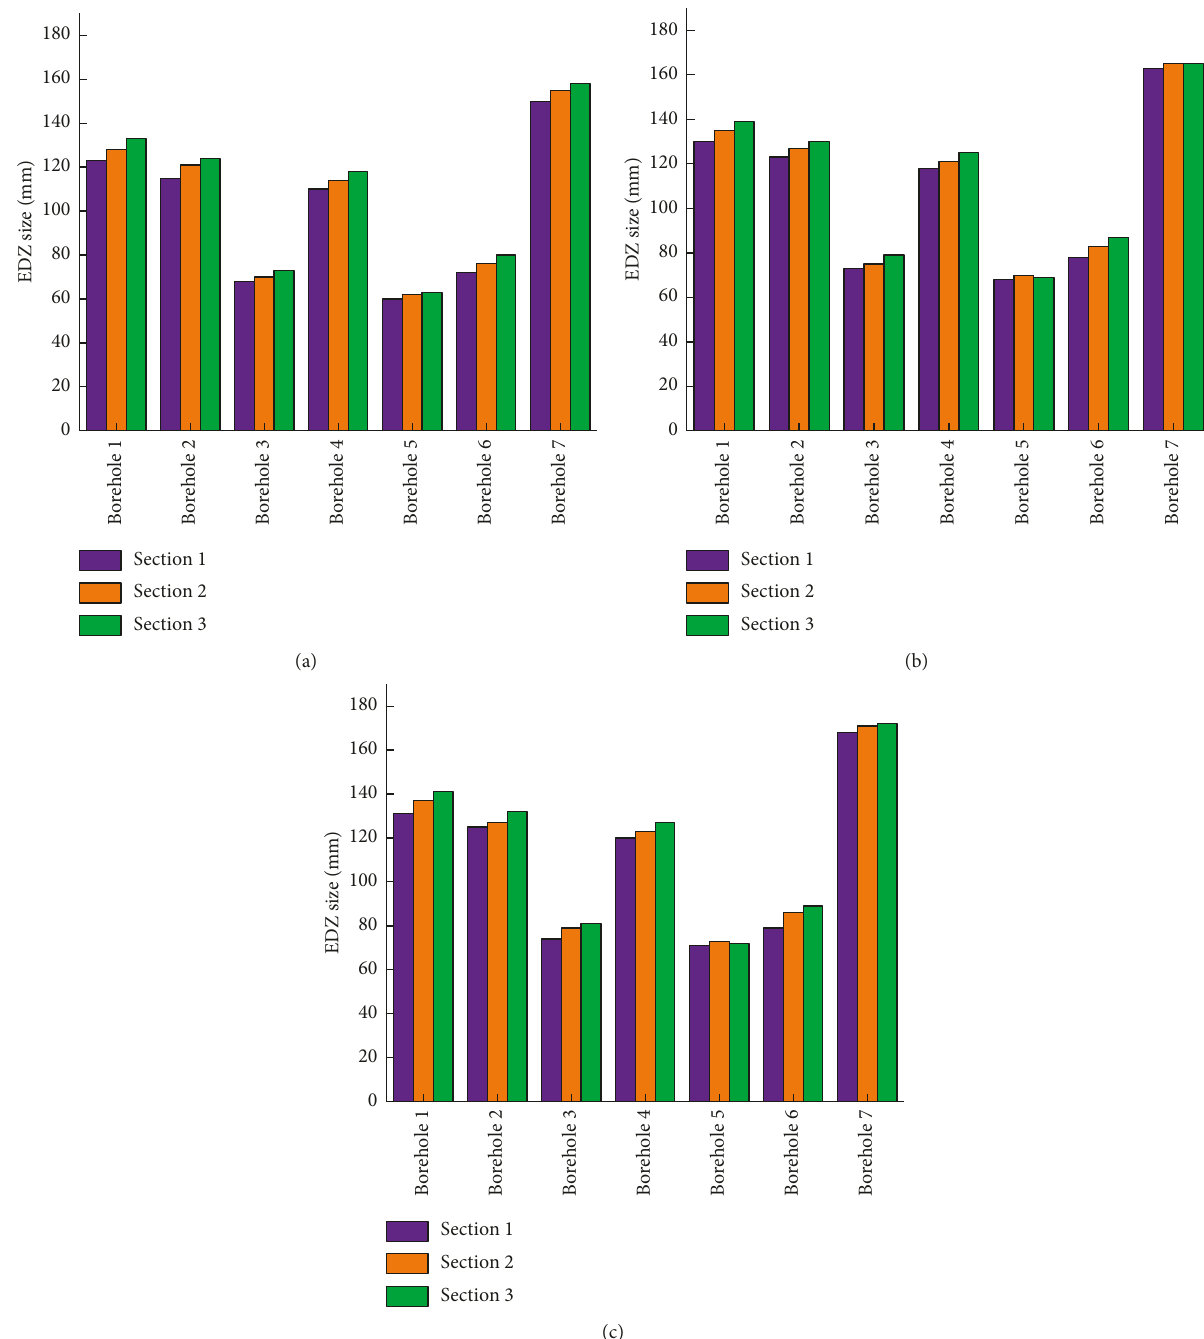
Figure 9: Space distribution laws for EDZ